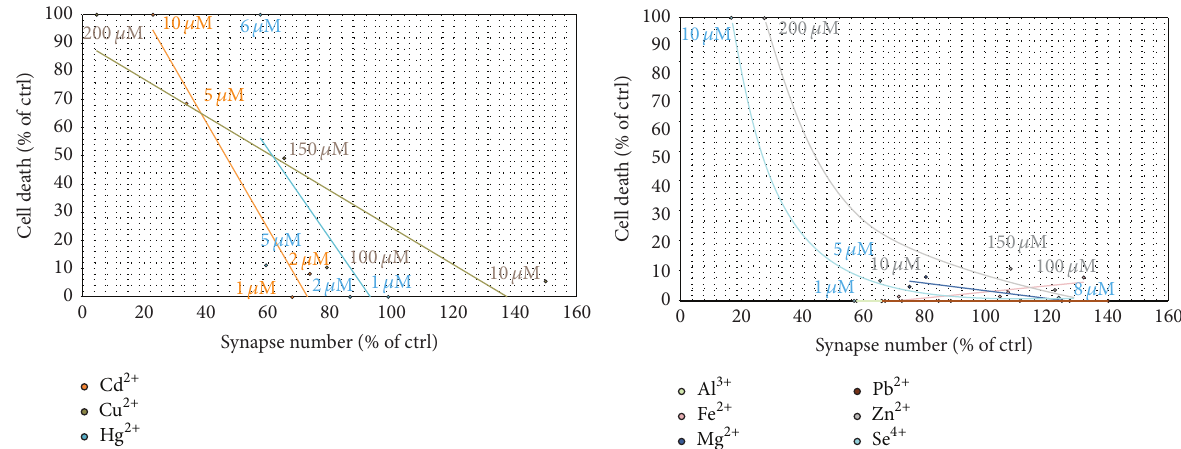
Figure 2: Effect of trace metals on synapse formation or stability. While the observed decrease in synapse number can be correlated with the overall cell death of neurons in culture for Cd, Cu, and Hg (left panel), no correlation was found for Al, Fe, and Pb that did not significantly alter cell health. Mg shows only a weak correlation due to its nontoxic effects on neurons over a wide concentration range. Both Zn and Se may display even increased synapse numbers despite ongoing cell